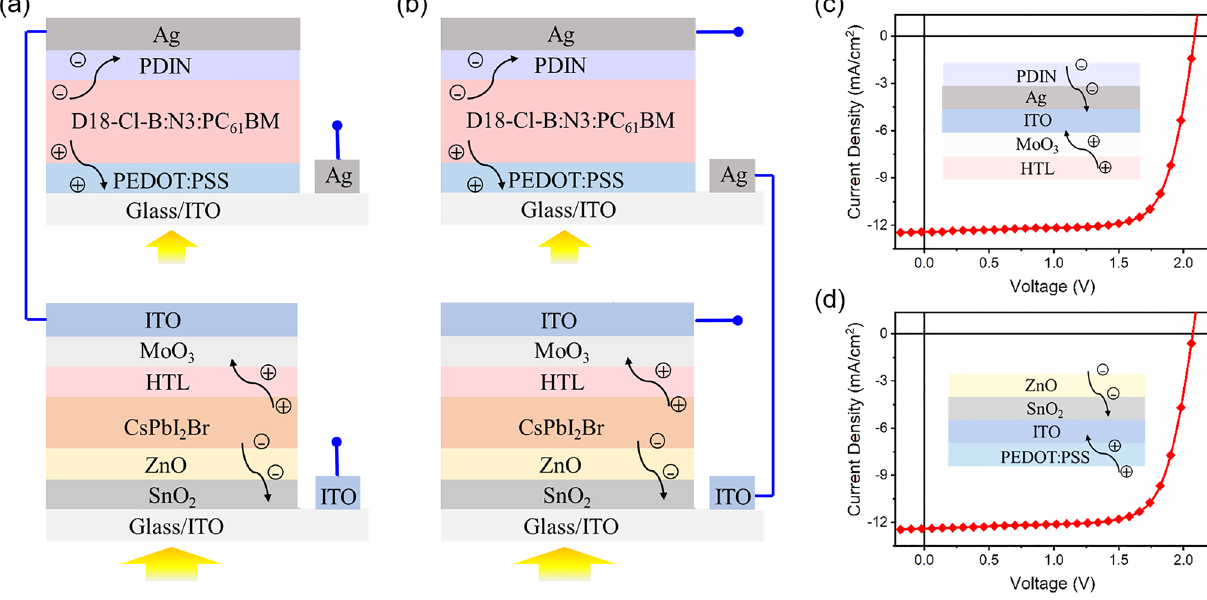
Fig. 4 a, b Illustration of the two connecting methods to make the equivalent 2-terminal tandem solar cells. c and d J–V curves for the tandem cells shown in a and b . The insets show the corresponding interconnecting layers